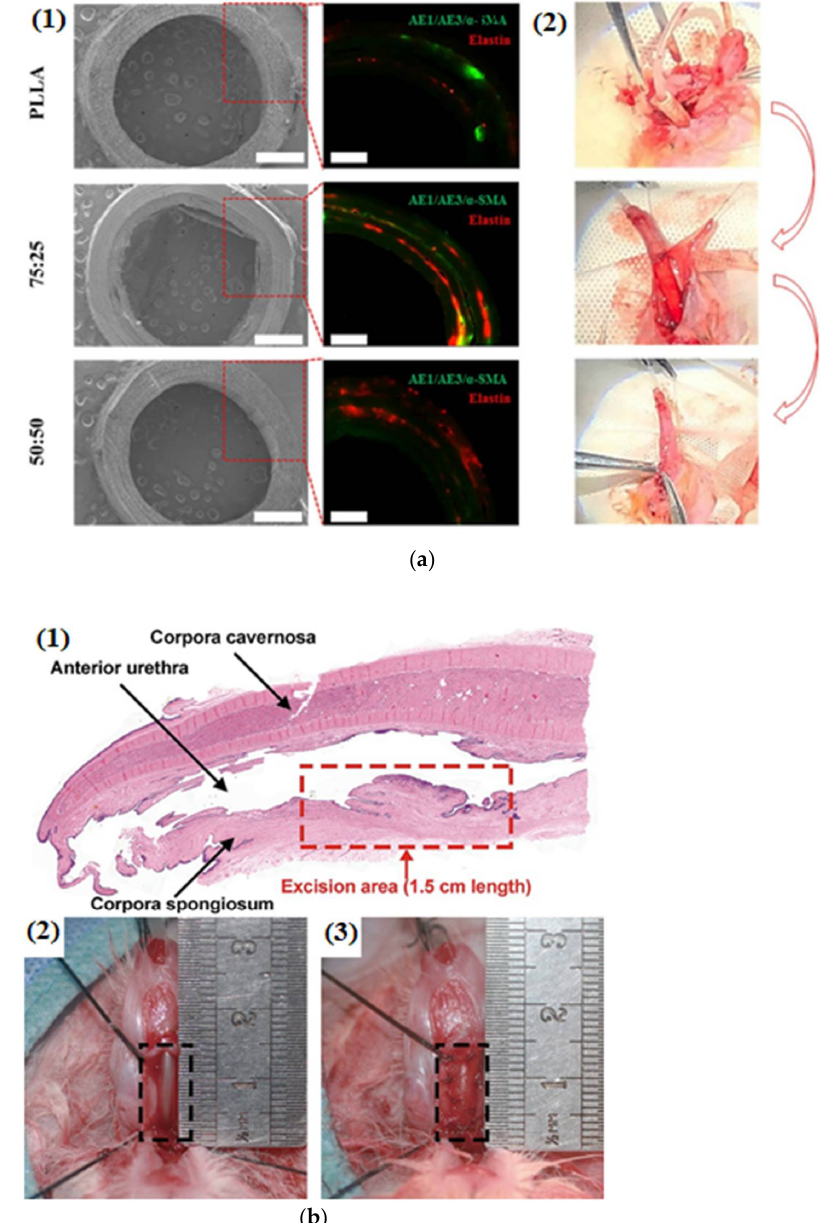
Figure 6. ( a ) Cellularized tubular autologous scaffolds and scaffold transplantation procedure. Scanning electron micrographs and fluorescent micro photos of the cross-section of each cellularized tubular autologous scaffold seven days after seeding (1). Left panels, scale bar 1 mm. Right panels, stained for keratin (AE1/AE3, green), elastin (red) in ECs, and actin (α-SMA, green), elastin (red) in SMCs on the cross-section of a tubular nanofibrous scaffold. Scale bar 400 μm. The cellularized tubular autologous PLLA/gelatine nanofibrous scaffold (2.2 cm in length) was sutured to the urethral defect site by an end-to-end anastomosis procedure (2). (For interpretation of the references to color in this figure legend, the reader is referred to the web version of this article.) (reproduced from [91] with permission of Elsevier, 2020), and ( b ) Substitution urethroplasty in vivo (1) Histological diagram of urethral defect rabbit model with an average length of a 1.5-cm ventral excision area. (2) Animal rabbit of the urethral defect. (3) Urethral reconstruction using composite scaffolds (reproduced from [92] with permission of Wiley, 2020) Also, a stromal cell-derived factor-1-alpha (SDF-1α)-aligned-(SF)/3D porous bladder cellular matrix graft (3D-BAMG) hybrid scaffold for long-section ventral urethral construction and repair in vivo was developed, as represented in Figure 6b. Aligned SF via electrospinning and wet approach. The hybrid scaffolds controlled stromal cell- derived factor-1 alpha release for over sixteen days in vitro. Stromal cell-derived factor-1- alpha-aligned- (SF) nanofiber supported reforming of urethral mucosa, submucosal smooth muscles, and microvasculature, enhanced cellular proliferation, and minimized collagen formation. Stromal cell-derived factor-1 alpha expression was improved in regeneration of urethra at three months post-surgery in SDF-1α-aligned-silk fibroin group [92]. Considering the complexities of the native artery wall structure and the challenges facing present treatment strategies, many works have been investigated to develop biomimetic tri-layers tissue-engineered vascular grafts [93]. A bio-inspired tri-layer tubular graft, employing biodegradable polymers. was investigated using multiple technologies to act as natural vascular architecture. The inner layer, composed of polycaprolactone (PCL) nanofiber, presents considerable tensile strength and improves endothelial cell adhesion and proliferation. The middle layer, made of polylactic-co- glycolide (PLGA) with a 3D porous structure, favors vascular smooth muscle cell (SMCs) breakthrough. Polyurethane (PU) was chosen to be the covering layer, for holding the entire tubular structure, and thermal crosslinking obtains interaction among the three